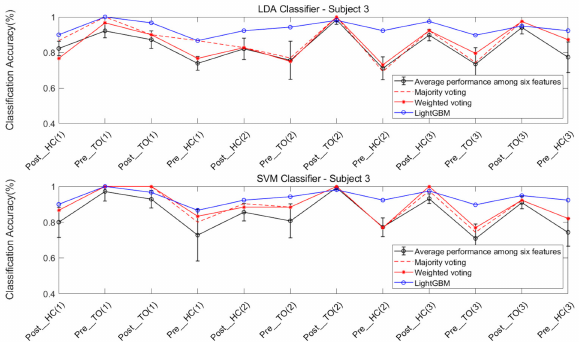
Figure 14. Classification performance for the ensemble learning method; Subject #3.